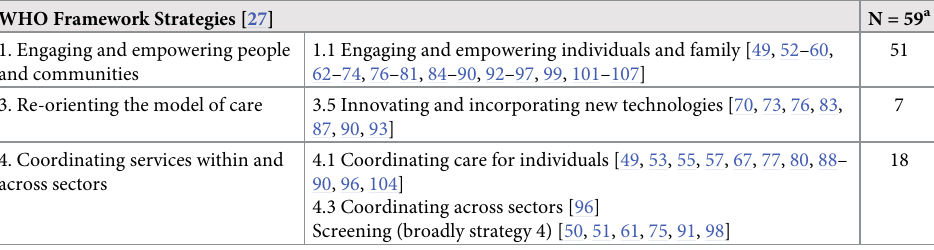
Table 4. Summary of WHO Framework strategies addressed by included